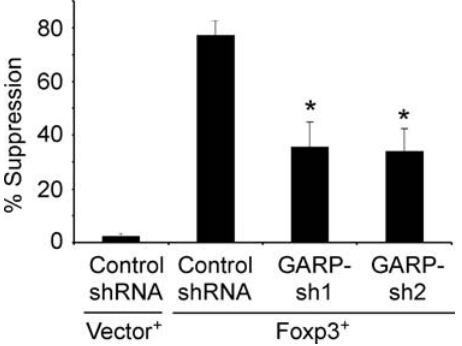
Figure 5. Silencing GARP in Foxp3-induced T regs attenuate their suppressive activity. CD4 + T cells were co-transduced with shRNA-expressing or control lentiviruses (GFP + ) and Foxp3-expressing lentiviral vectors (RFP + ). GFP + RFP + T cells expressing both shRNA for GARP and Foxp3, were first sorted to high purity through FACS. The suppressive activity of these cells were then determined using CFSE assay and represented as percent suppression as described in detail in Figure 3. Data are representative experiments from two different donors and shows independent results from two separate shRNAs against GARP. Data represent the mean 6